Question: Summarize what this figure shows in one sentence.
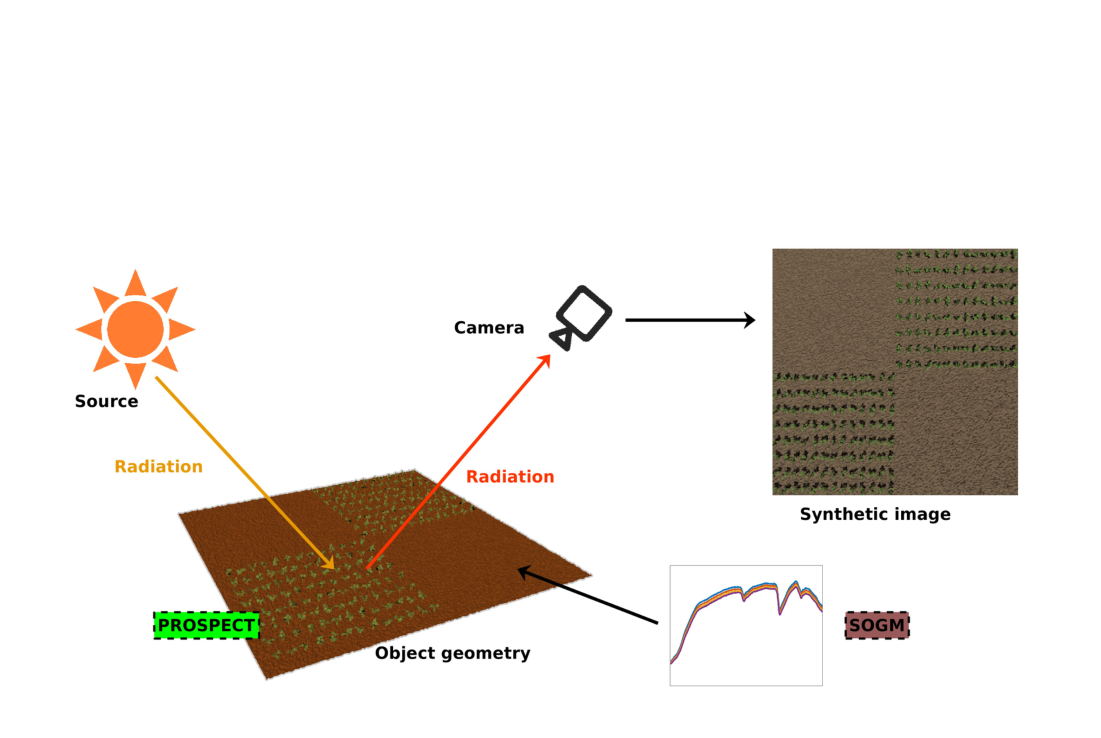
Answer: Schematic representation of the 3D radiation model for image generation. A ray-tracing- based camera model is used to simulate radiation that is emitted from a radiation source (e.g., sun, LED light) and reaches the camera after being scattered by objects in the scene. The PROSPECT- based leaf optical model and SOGM can generate the leaf and soil optical properties, respectively. Finally, the simulated camera generates resulting images that can be arbitrarily auto-annotated.